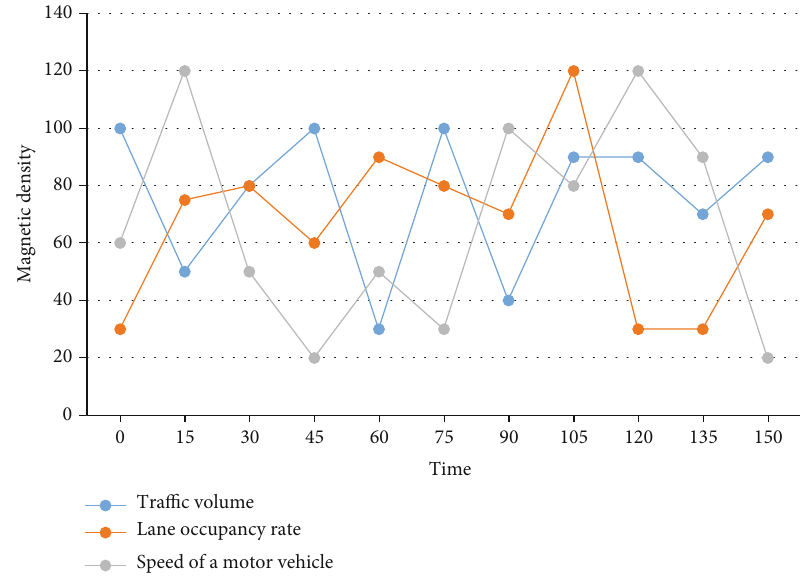
Figure 7: Vehicle identi fi cation